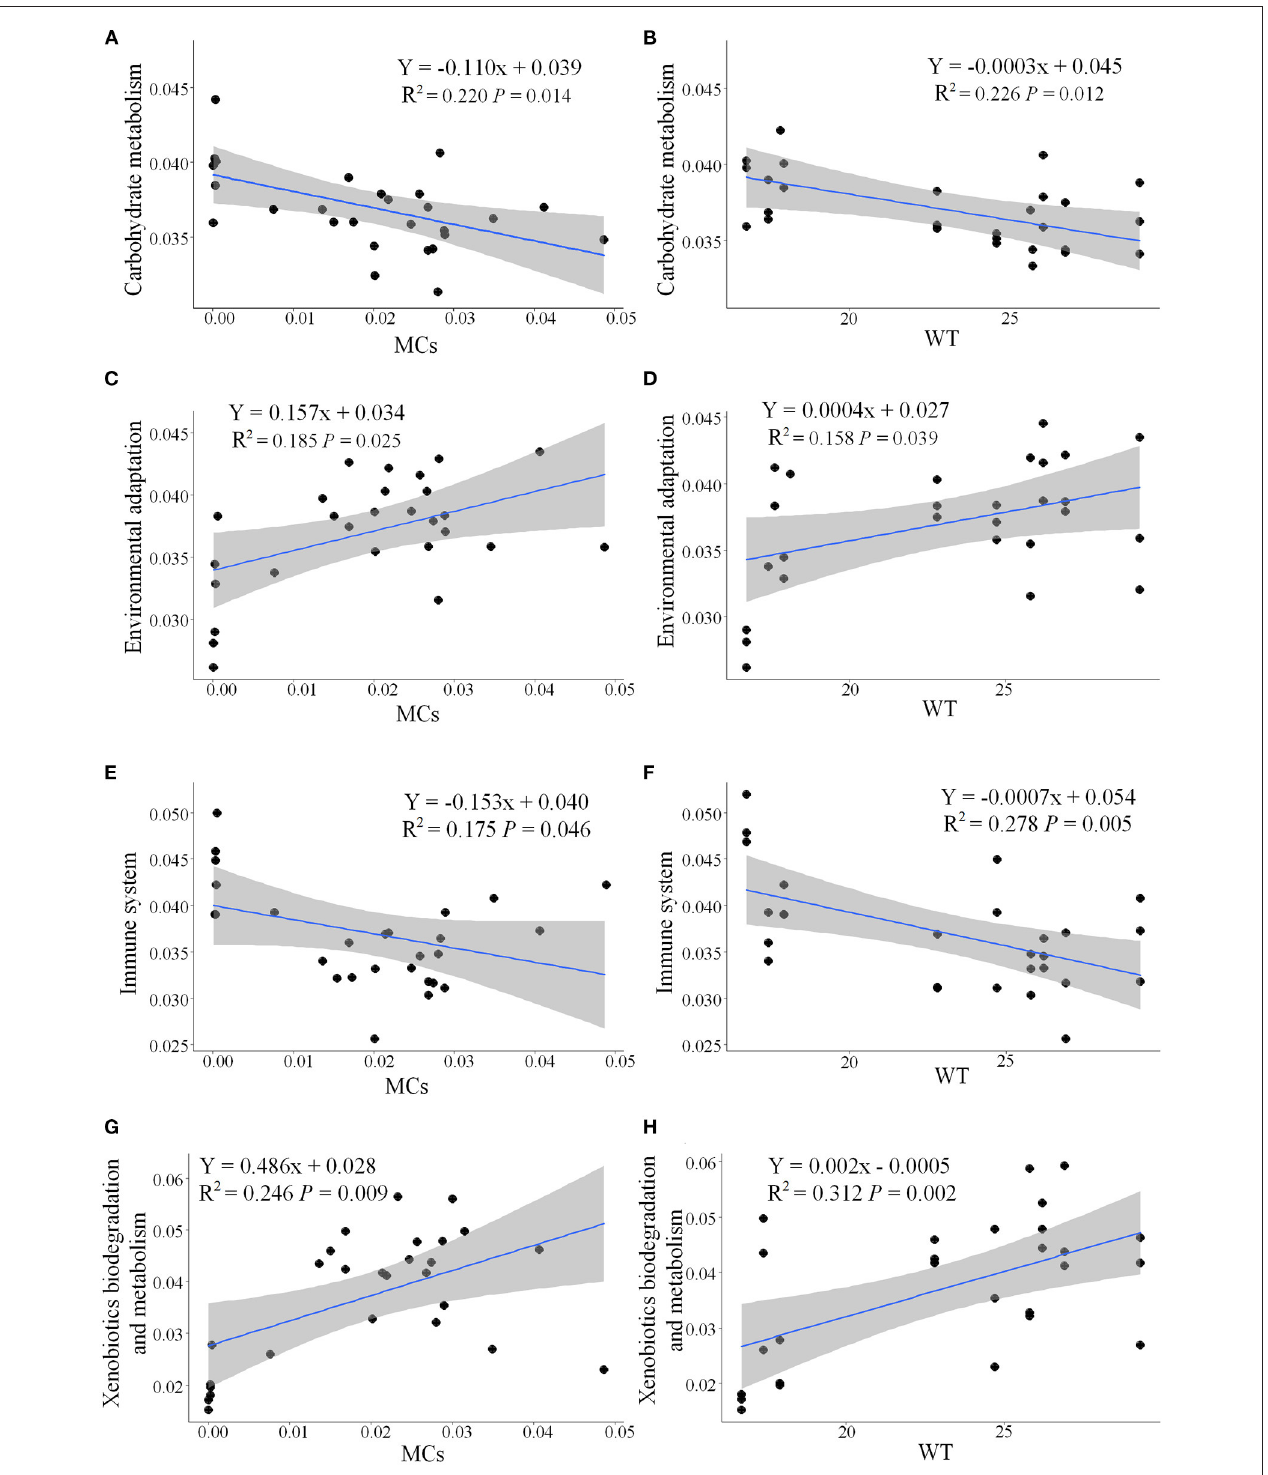
FIGURE 9 | Linear relationships among the pathways carbohydrate metabolism (A,B) , environmental adaptation (C,D) , immune system (E,F) , and xenobiotics biodegradation and metabolism (G,H) and changes in MCs and WT. The R 2 values represent correlation coefficient, P -values represent significant differences ( P < 0.05). The gray-shaded area represents a 95% confidence